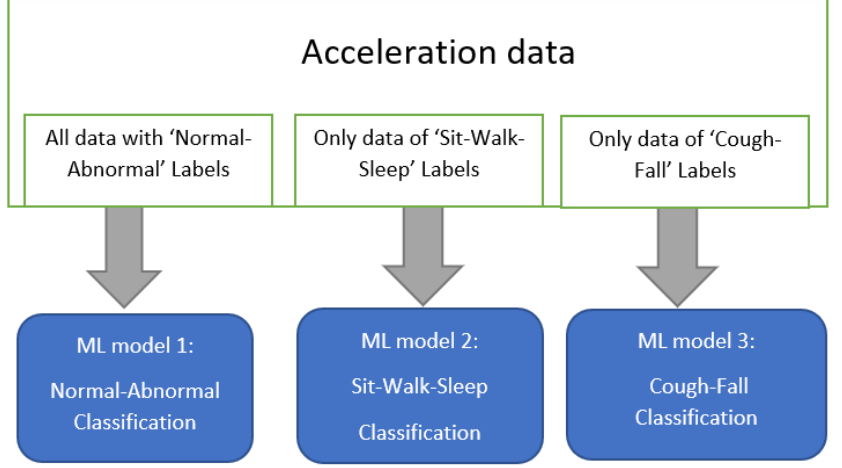
Figure 5. Parallel training models.